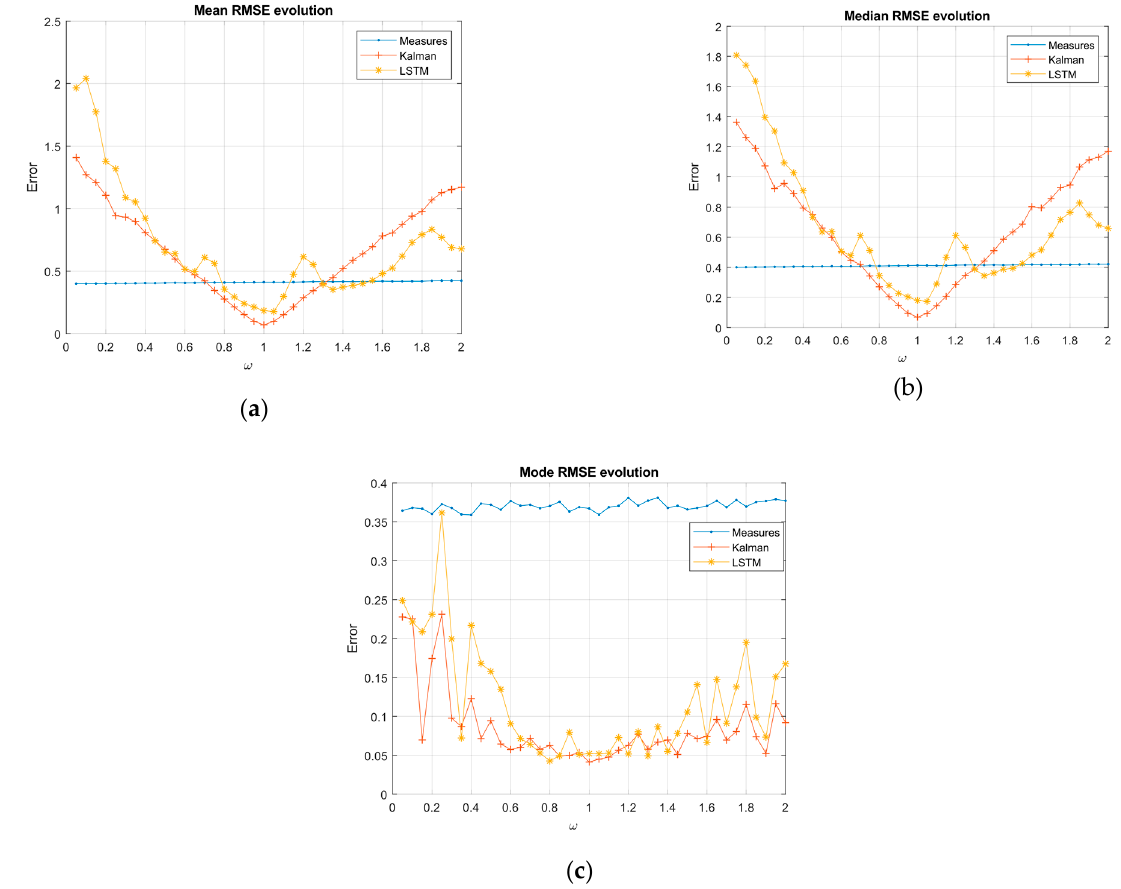
Figure 5. RMSE evolution as the independent term changed in the sinusoidal measurements model: ( a ) RMSE mean, ( b ) RMSE median, and ( c ) RMSE mode.